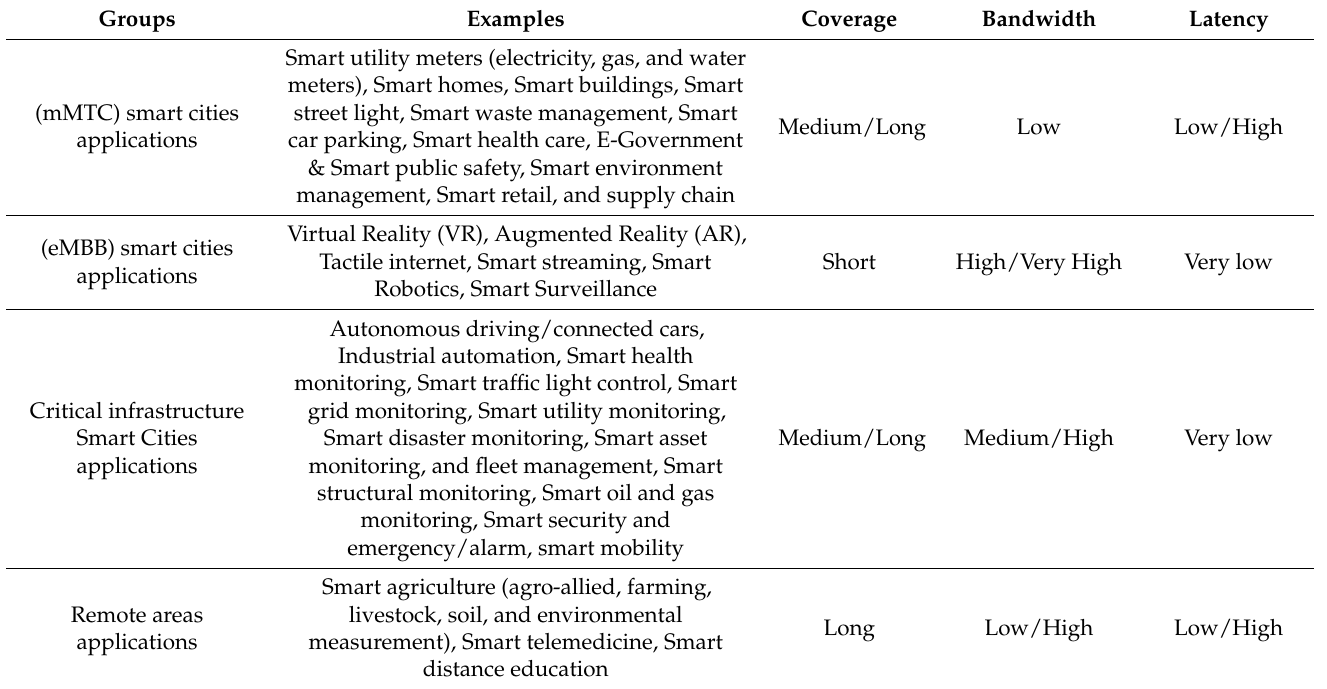
Table 4. Smart Cities Application